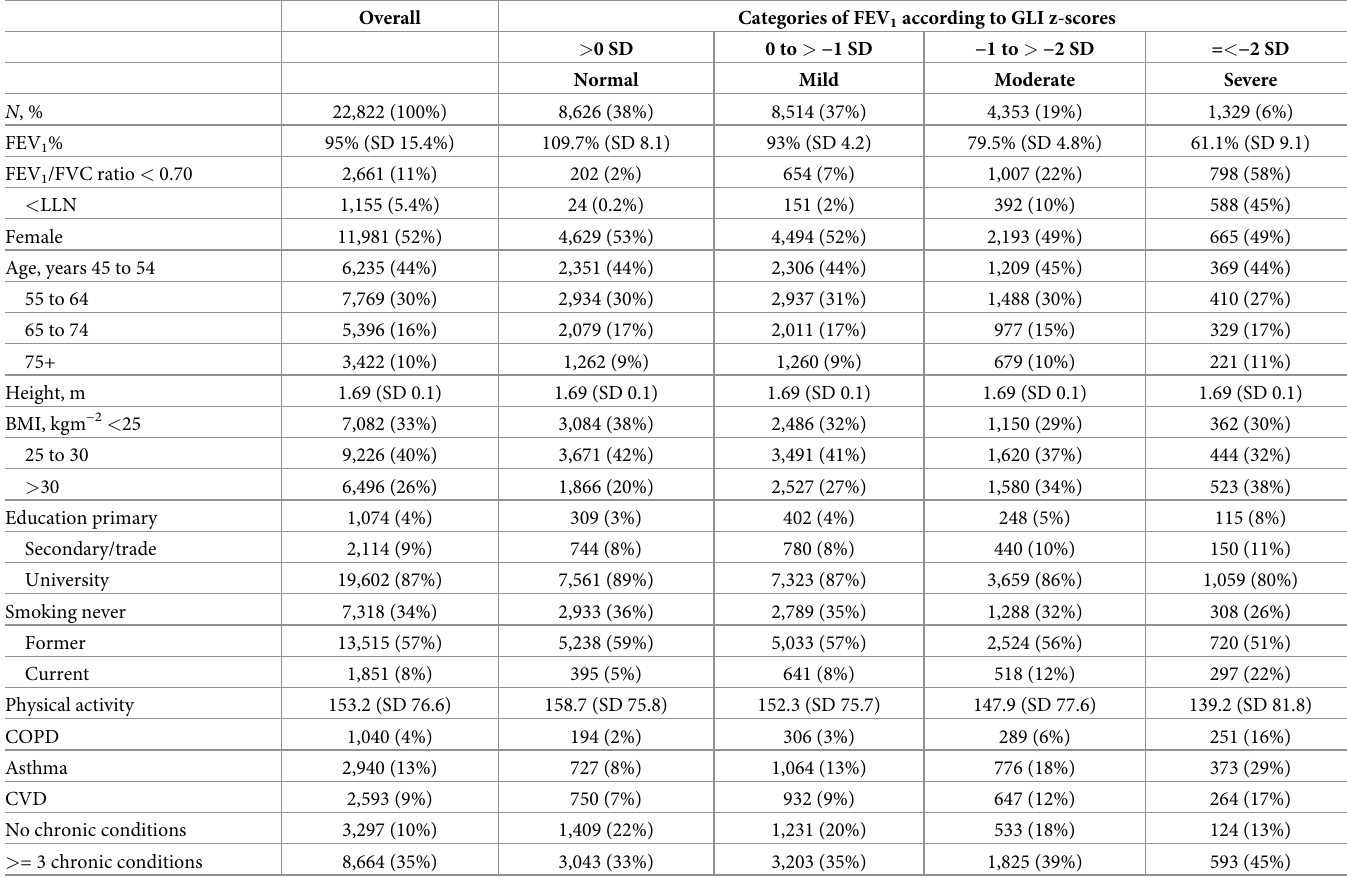
Table 1. Baseline characteristics by categories of FEV 1